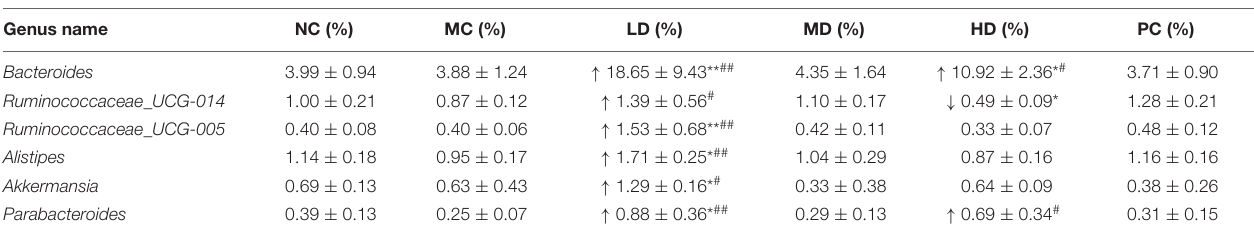
TABLE 4 | Effects of BRS on gut bacteria at the genus level.